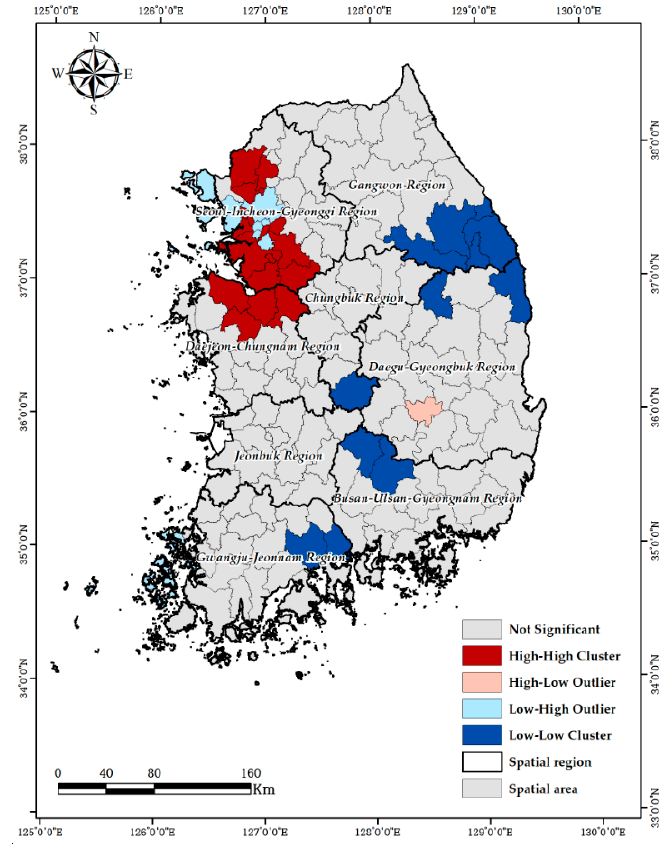
Figure 6. Map of spatial clusters and spatial outliers in forest loss area in South Korea.